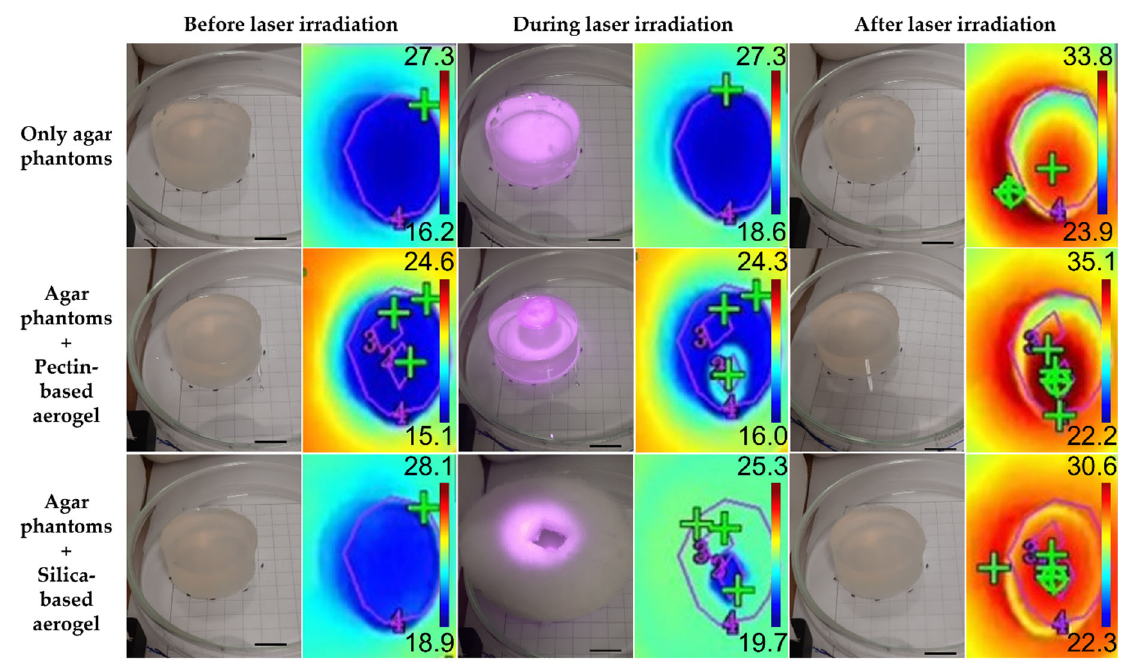
Figure 5. Real and thermal images of agar phantoms before, during (after 1 min of irradiation) and after laser irradiation. Scale bar: 1.3 cm.